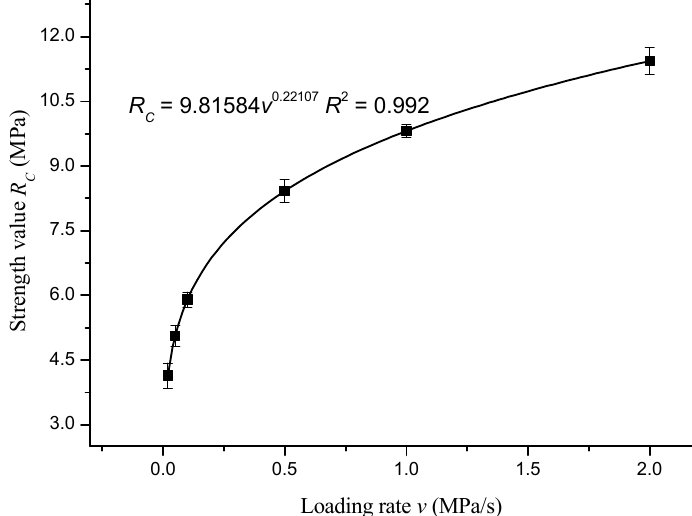
Figure 5. Unconfined compressive strength versus loading rate of asphalt mixture.